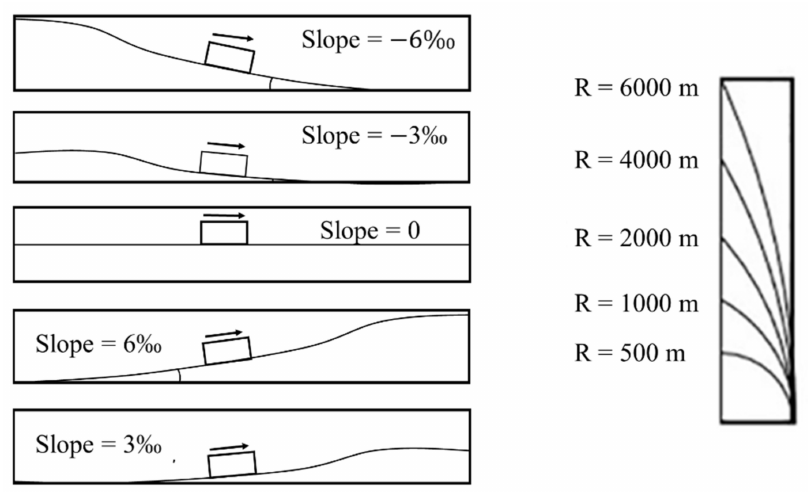
Figure 2. Schematic diagram of slope and curve radius (R).